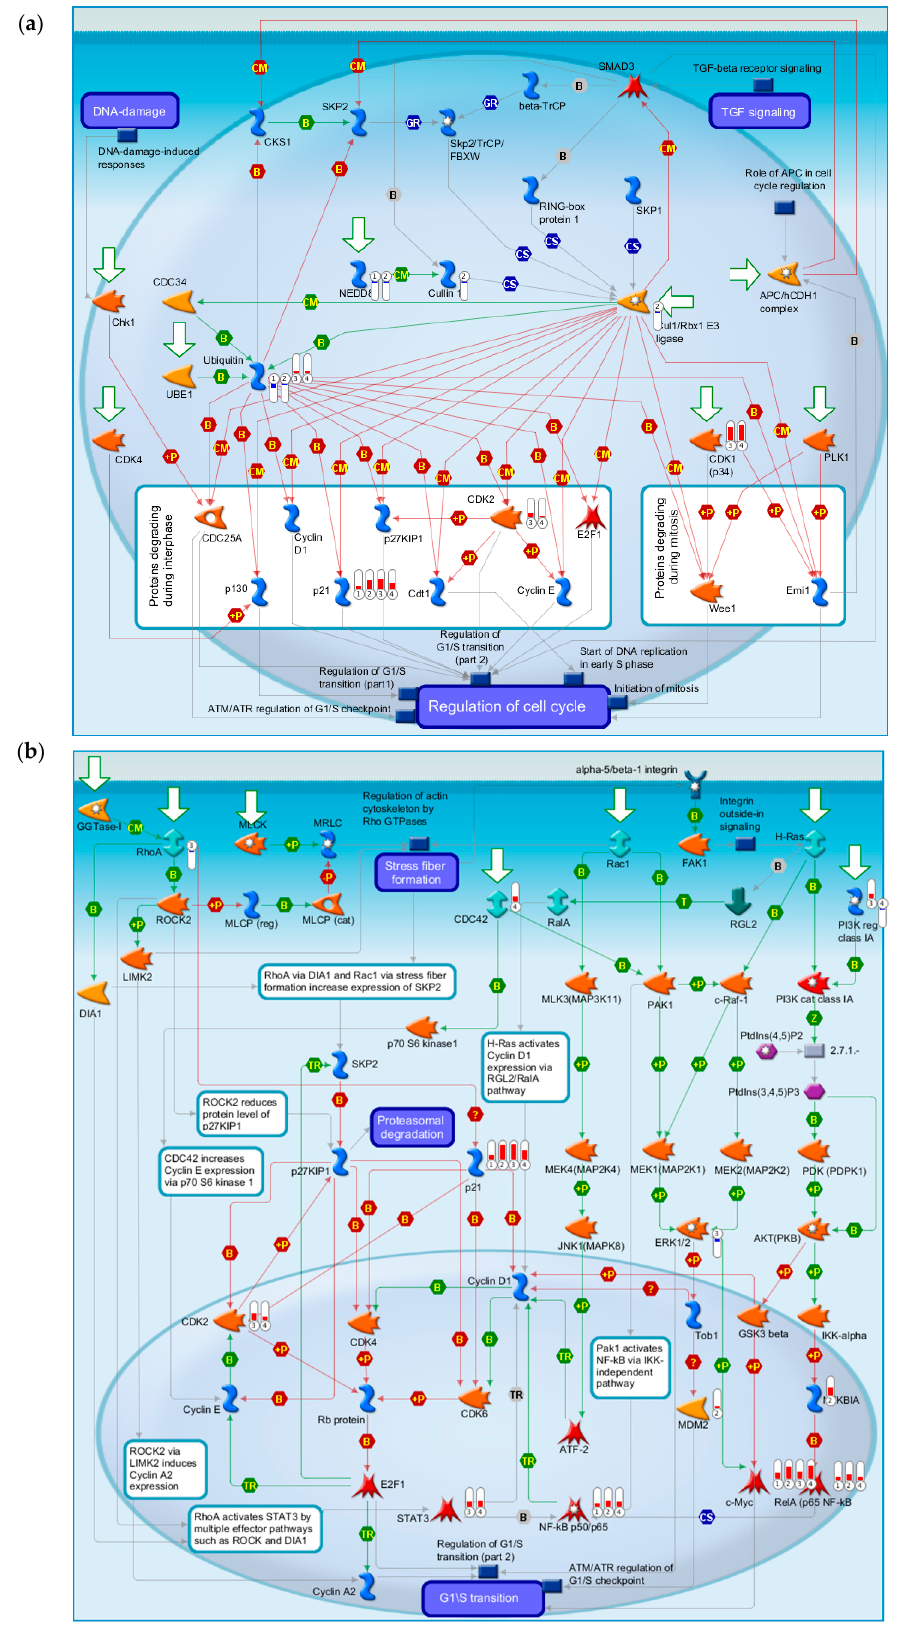
Figure 5. The highest-scoring and fifth highest-scoring pathway maps for the last two time points post-TBI (24 and 72 h). ( a ) Cell cycle: role of SCF complex in cell cycle regulation; ( b ) Cell cycle: Influence of Ras and Rho proteins on G1/S Transition. These figures were generated by MetaCore™.